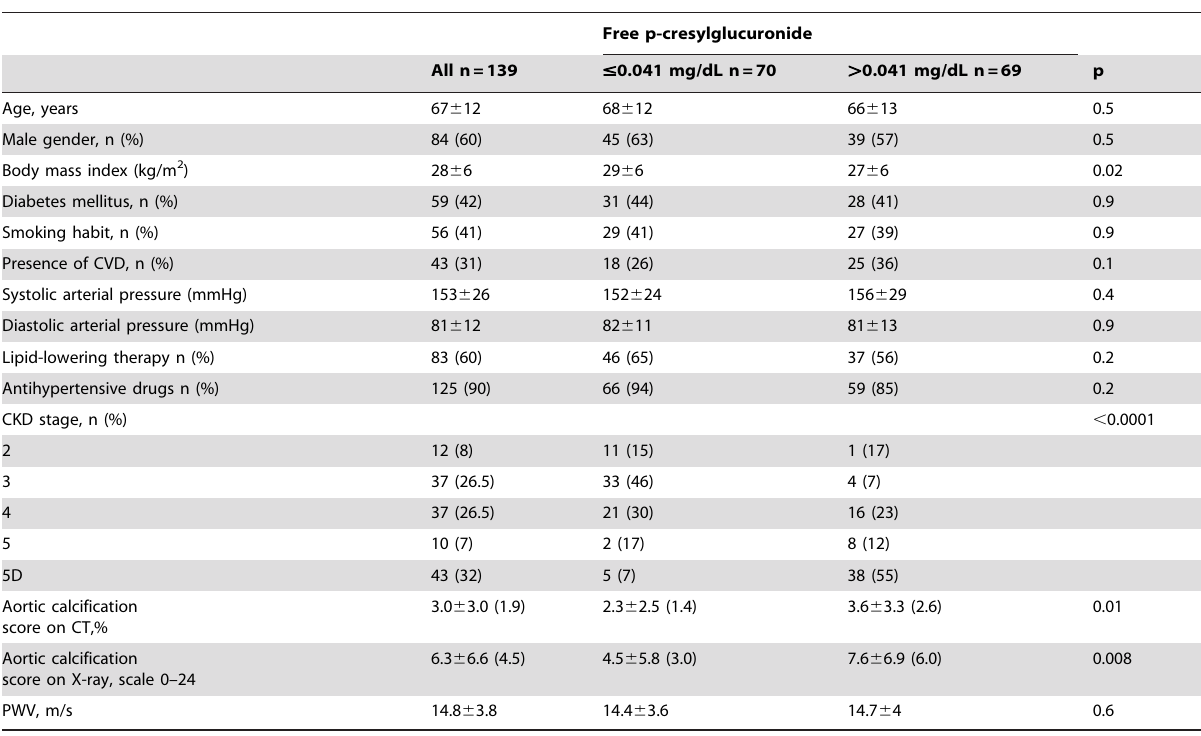
Table 1 . Clinical and demographic characteristics of the study population.